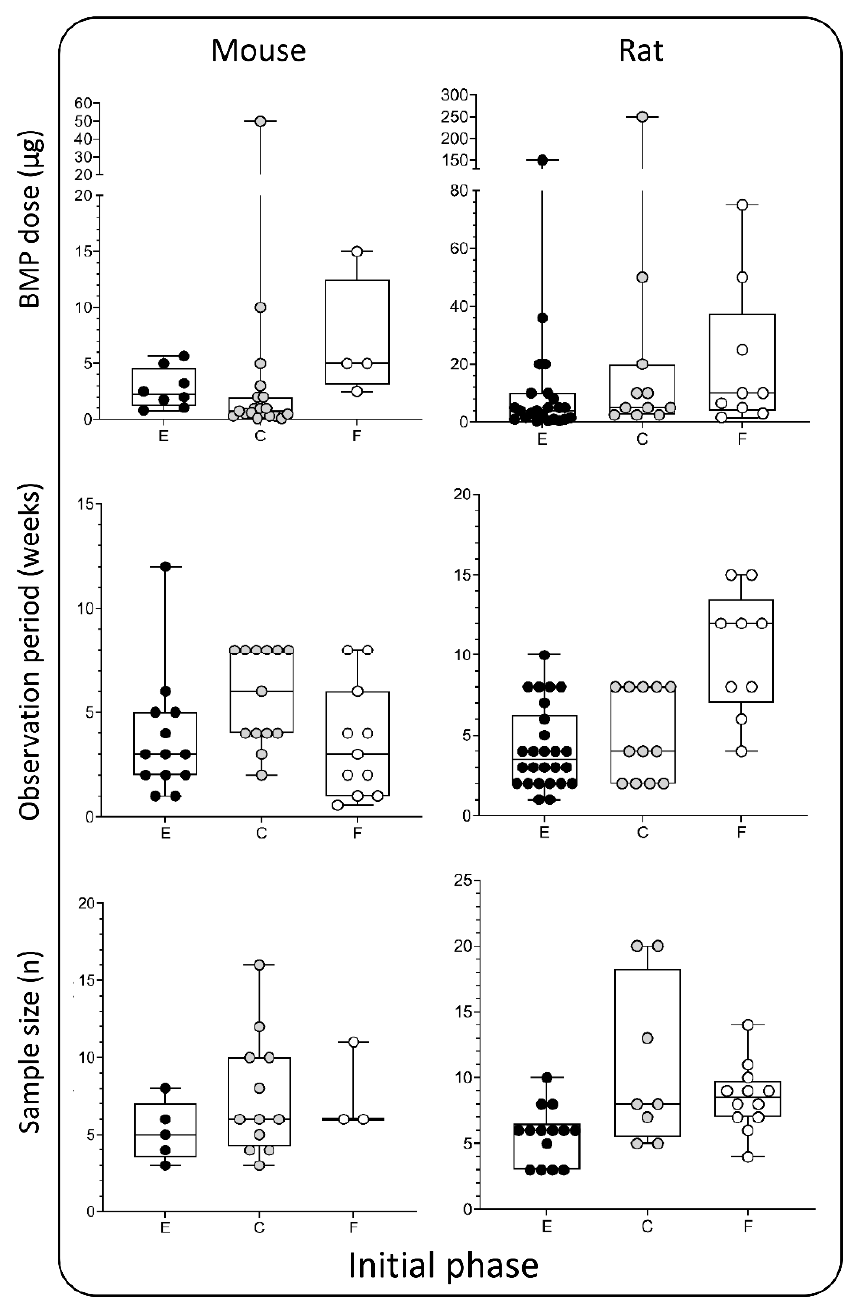
Figure 4. BMP doses (µg), observation period (weeks), and sample size ( n ) used in the initial phase —rodent models. Data is presented through box and whisker plots in which dots represent all individual values from studies listed in Tables 1 and 2. E—ectopic model, C—calvarial, and F— femoral defect.